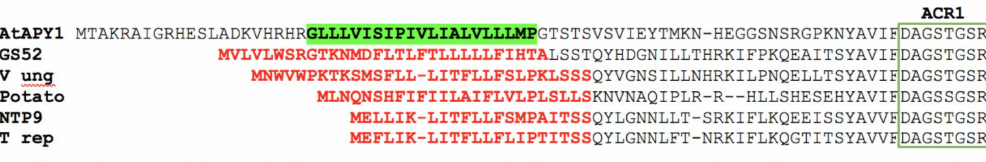
Figure 3. Sequence alignments of the N-terminal regions of plant APYs. The multisequence alignment was generated using Clustal Omega [55]. TOPCONS webserver [54] predictions are shown in bold. The predicted single-pass outward-facing transmembrane helix in the AtAPY1 sequence is highlighted in green. Bold red indicates predicted secretion peptide sequences. Relative positions of these N-terminal sequences to the ACR1 sequence motif (green box) are shown, the latter of which is present in the globular portion of all homology models and crystal